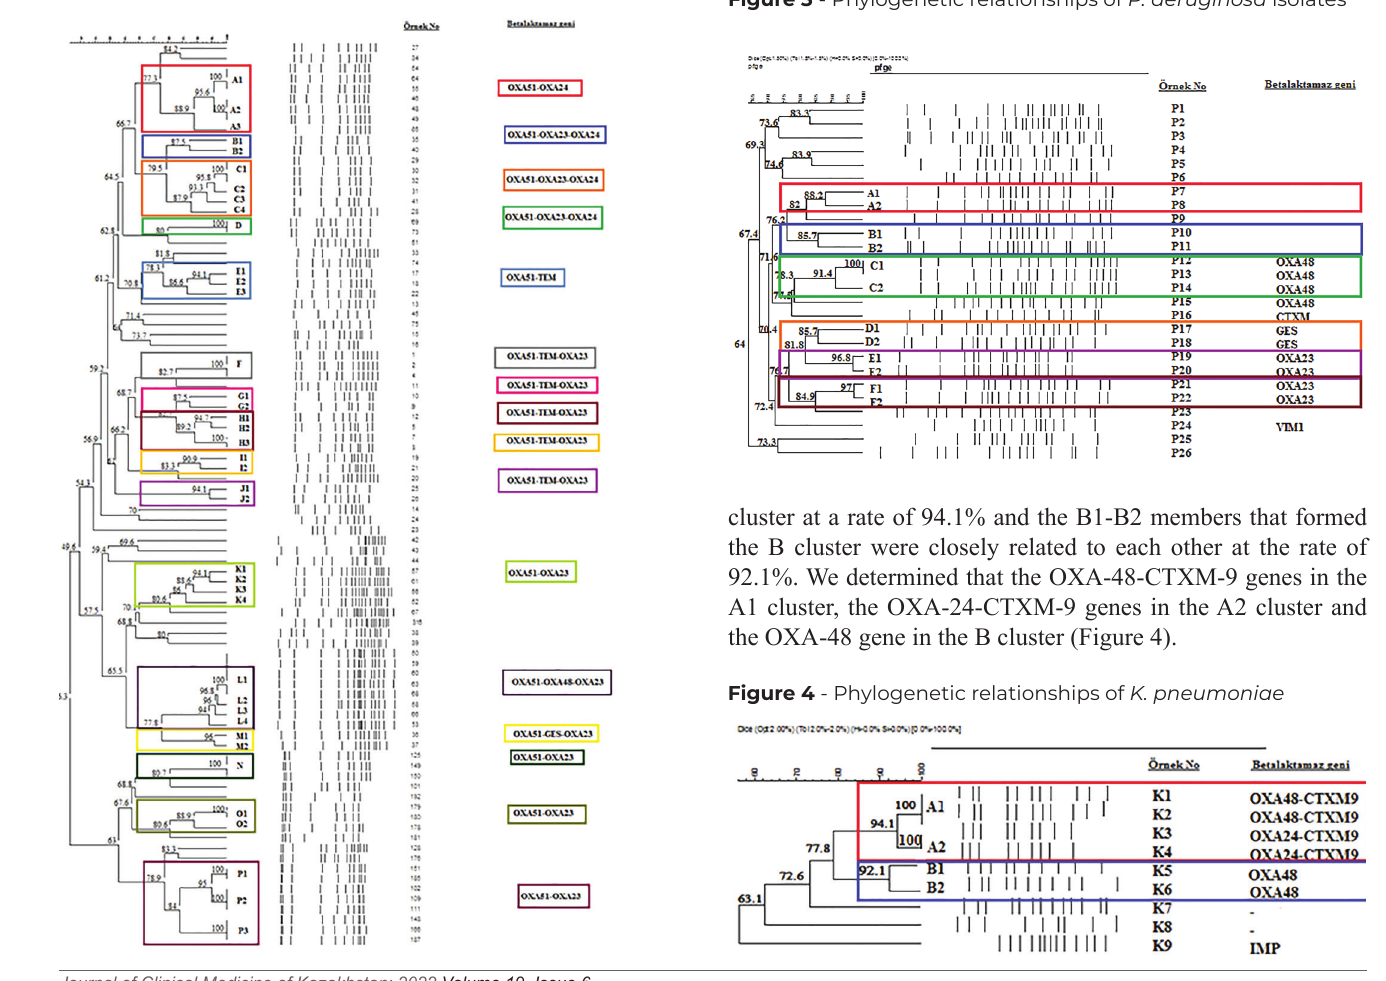
Figure 3 - Phylogenetic relationships of P. aeruginosa isolates